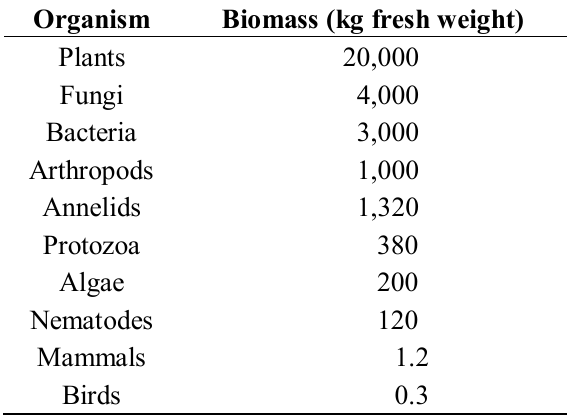
Table 1. Biomass of various organisms per hectare in a temperate region pasture